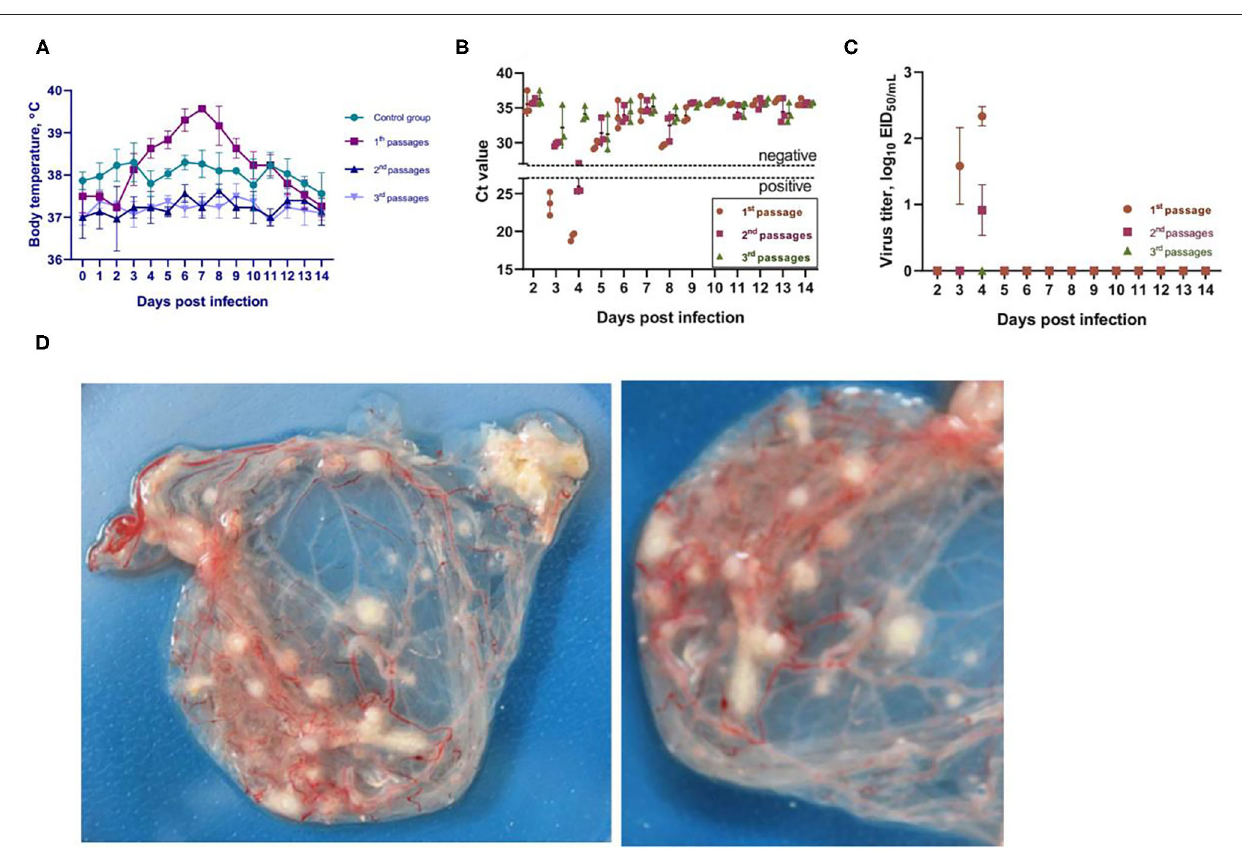
FIGURE 3 | Reversibility testing of an attenuated KM-40 strain of camelpox virus. (A) Temperature response of vaccinated and control camels analyzed for vaccine strain reversibility. (B) PCR results for detection of viral DNA in the blood of infected animals. In the blood of infected camels sampled on days 3 and 4 after infection, viral DNA was detected at the first and second passages, whereas no virus DNA was detected in the blood of infected camels at the third passage. Ct values between 16 and 25 are positive, while Ct values ≥ 30 are negative. (C) Virus titer on CAM of the ECE in blood samples collected on days 3 and 4 after infection. (D) characteristic of the formation pock lesions on CAM of the